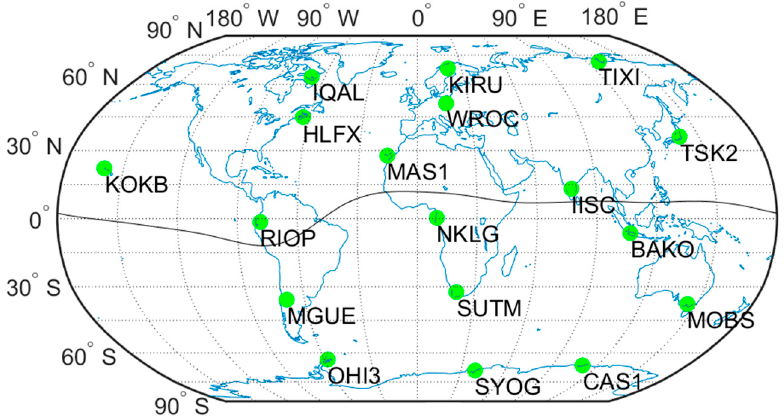
Figure 2. Distribution of IGS stations used for GNSS-STEC comparisons.